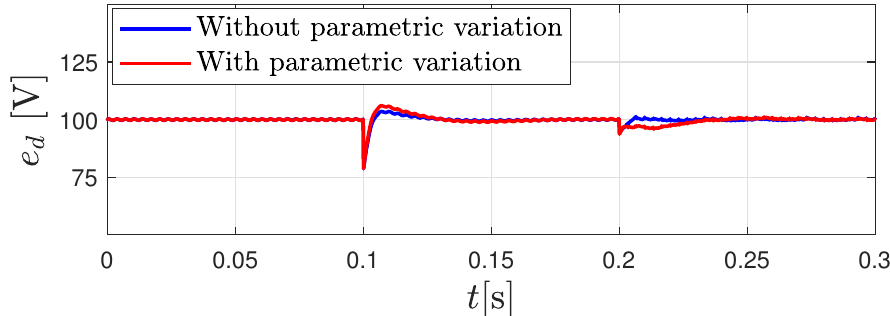
Figure 6. Behavior of d -axis voltage for parametric variation.